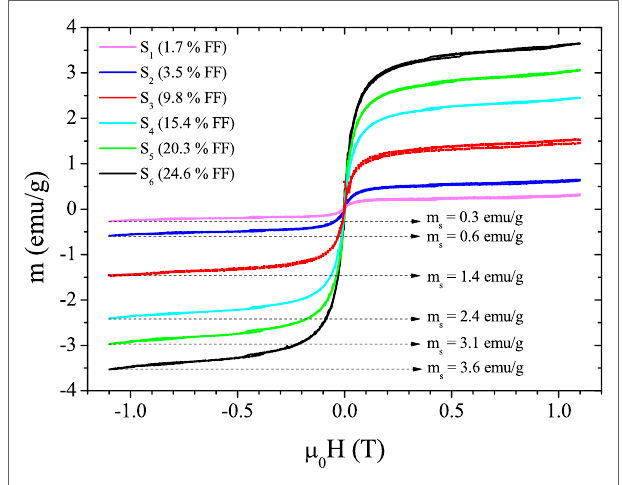
FigUre 4 | Magnetic loops for samples s 1 –s 6 at room temperature for different ferrofluid concentration as a function of the applied magnetic field .